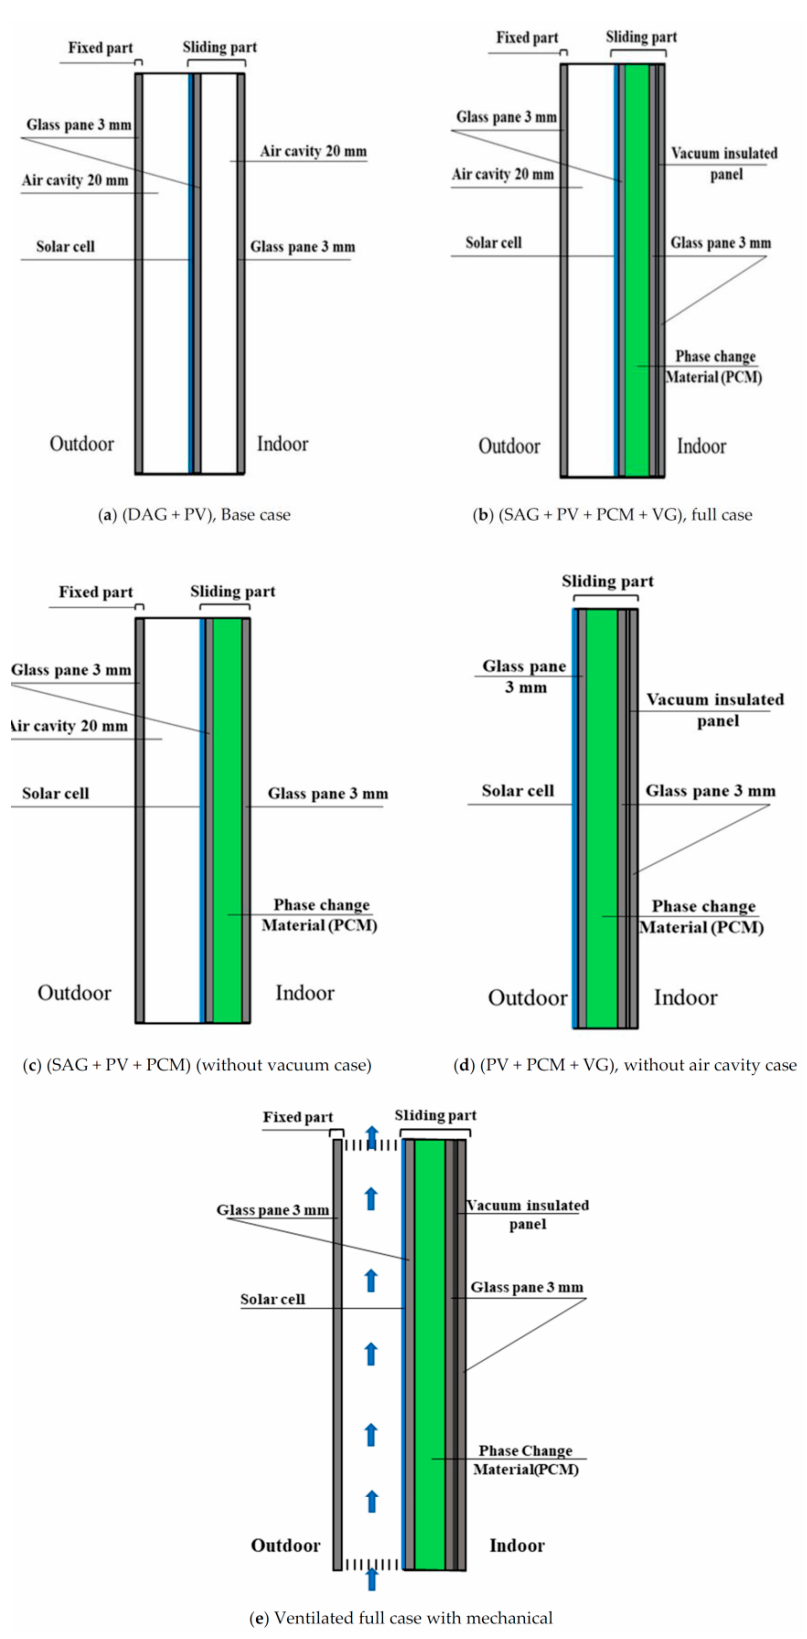
Figure 18. Different proposed windows by Ahmed et al. [60] showing: ( a ) base case, ( b ) full case, ( c ) without vacuum case, ( d ) without air cavity case, and ( e ) mechanical ventilated full case.